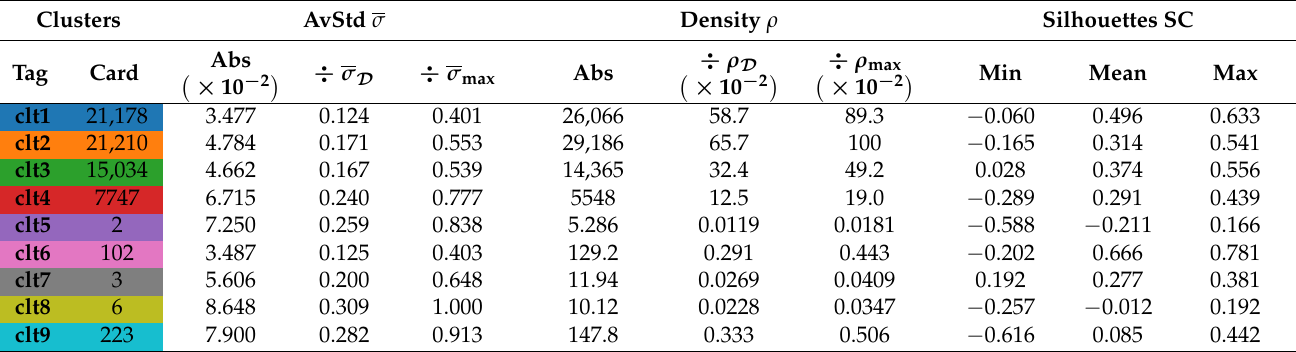
Table 5. Battery 1 quantification of the clustering: AvStd, density, and silhouettes. For the first two tags, “Abs” represents the absolute value of quantifier γ , “ ÷ γ D ” is this value divided by that of database D 1 , and “ ÷ γ max ”, divided by the maximal value of γ among the nine clusters. For the silhouettes, there are as many coefficients as data in a cluster: “Min”, “Mean”, and “Max” are, respectively, the minimum, mean, and maximum values among all the silhouettes of a cluster. See Table 3 for the details about the color